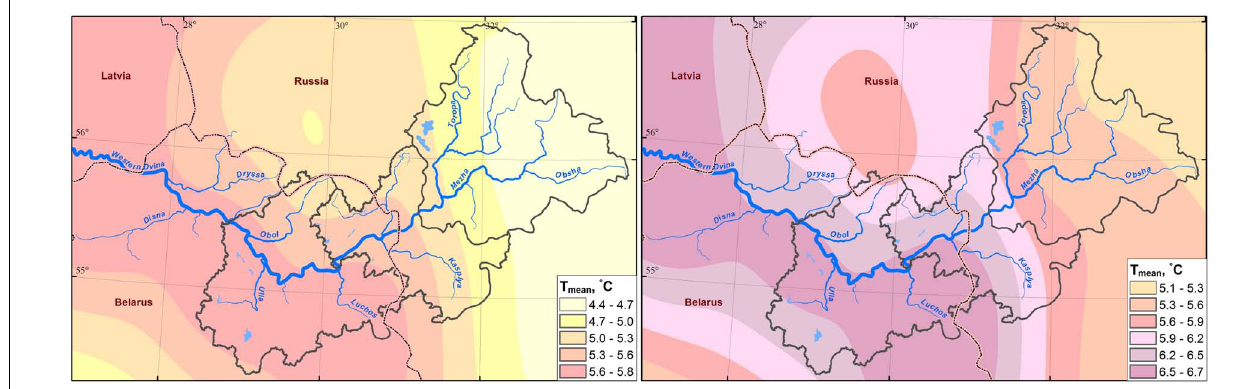
FIGURE 5 | The spatial distribution of the annual temperature mean values over the Western Dvina River Basin for two different periods: 1945 to 2015 (left) and 1989 to 2015 (right) .